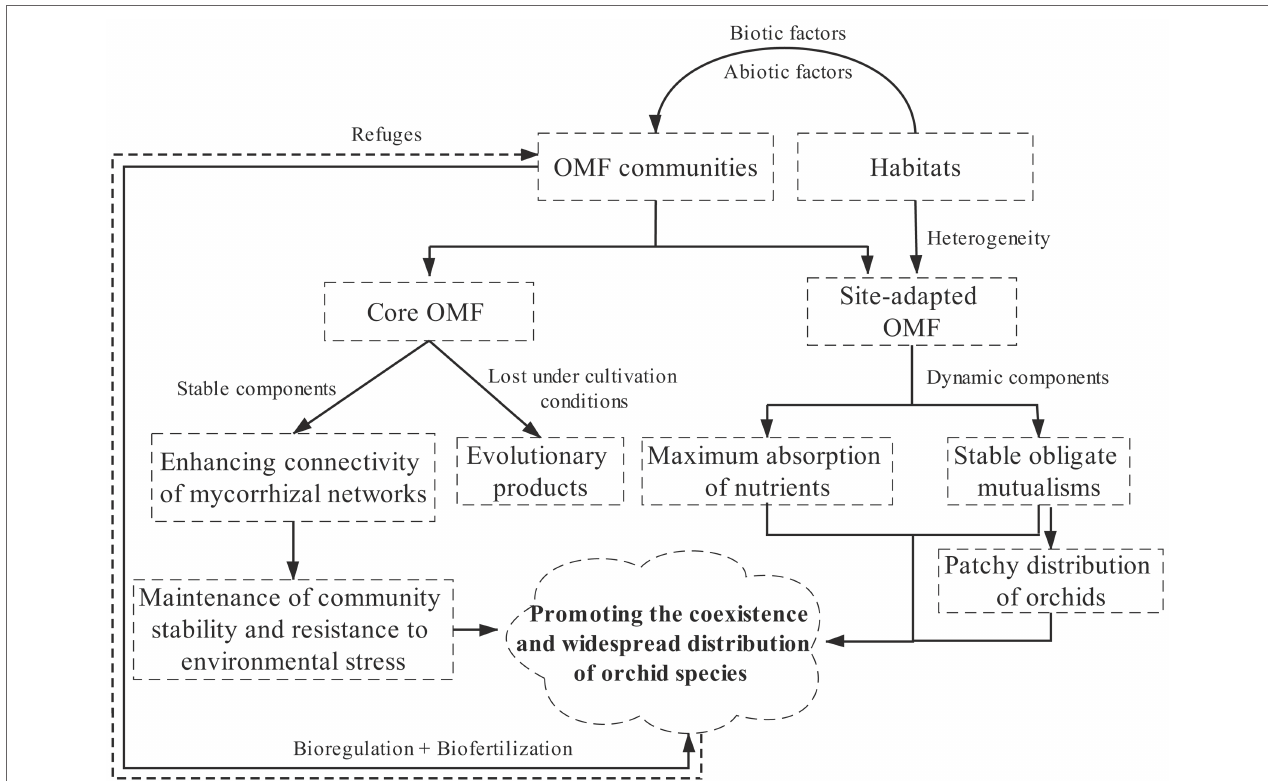
FIGURE 1 | A framework depicting how habitats indirectly affect the coexistence and widespread distribution of orchid species by affecting OMF communities. OMF communities shaped by different habitats affect the growth and development of orchids (bioregulation) by promoting nutrient absorption (biofertilization). The dotted arrow indicates that the current understanding of the impact of orchids on OMF life cycle is very